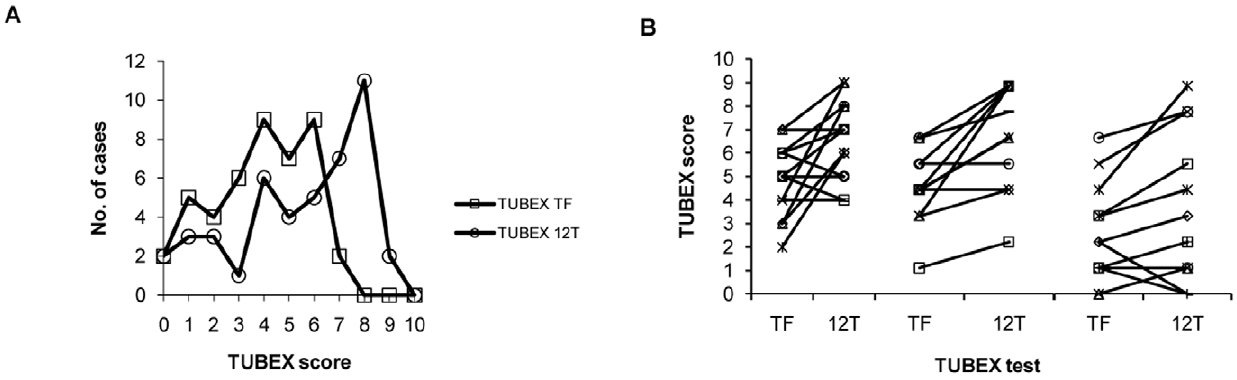
Figure 4. Comparison of the results scores between TUBEX TF and TUBEX 12T in typhoid patients. Based on the frequency of the various scores (0–10) (A), or on each individual patient (total 22 patients) (B).